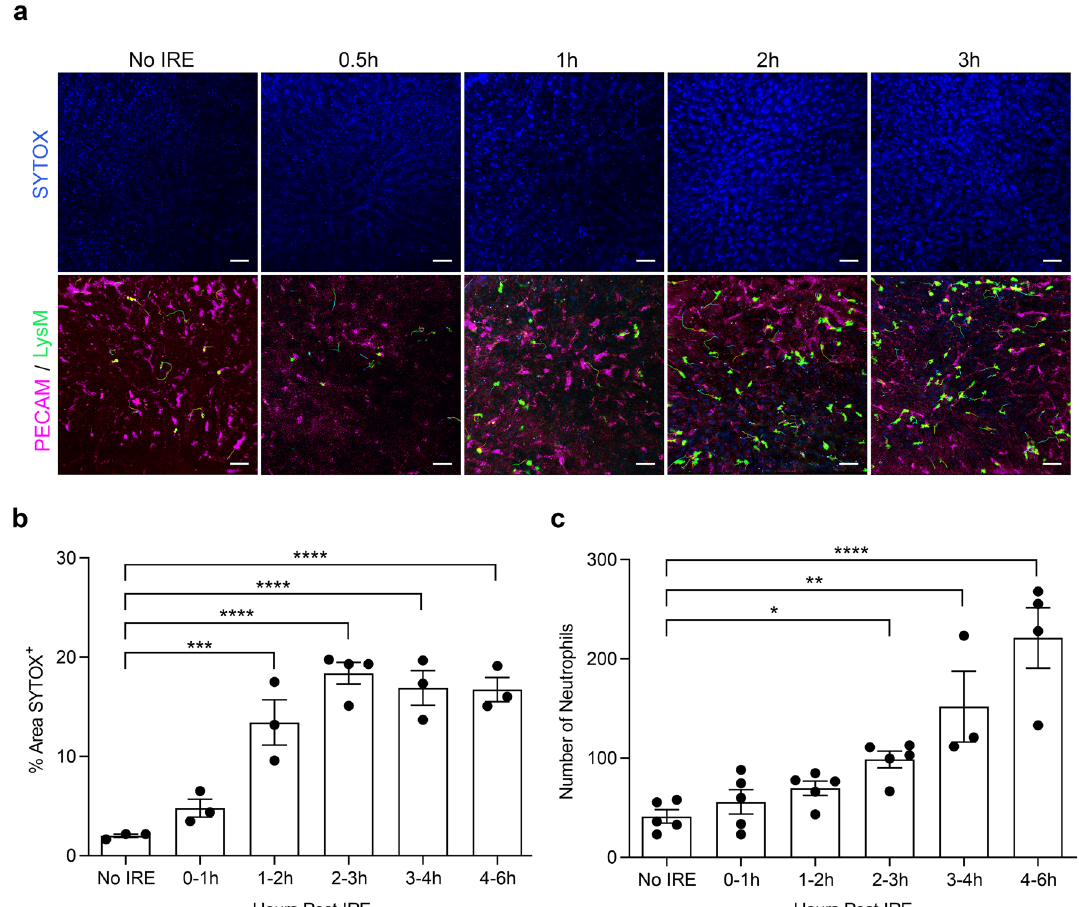
Figure 1. Intravital imaging demonstrates patent microvasculature, delayed cell death, and neutrophil recruitment after IRE. ( a ) LysM-eGFP mice, in which neutrophils express eGFP, were given intravenous anti-PECAM-1-PE to label endothelial cells and SYTOX Blue to identify dead cells. Intravital imaging of the liver was performed without IRE or at early timepoints after 1500 V/cm IRE treatment. ( b ) Percentage of liver parenchyma area positive for SYTOX per intravital image field (500μmx520μm field of view with 25 × objective) was determined at baseline (No IRE) and at the indicated time spans after IRE treatment. ( c ) Numbers of neutrophils (eGFP + cells) per intravital image field were counted at baseline (No IRE) and at the indicated time spans after IRE treatment. For ( b , c ), one-way ANOVA shows significant differences between No IRE and all of the time brackets after IRE ( p < 0.0001). Post hoc multiple comparison with Holm–Sidak correction of each time bracket to the No IRE baseline demonstrates * p < 0.05, ** p < 0.01, *** p < 0.001, and **** p < 0.0001. Individual points represent independent animals (n = 3–5 per condition). Graph bars and error bars show mean ±